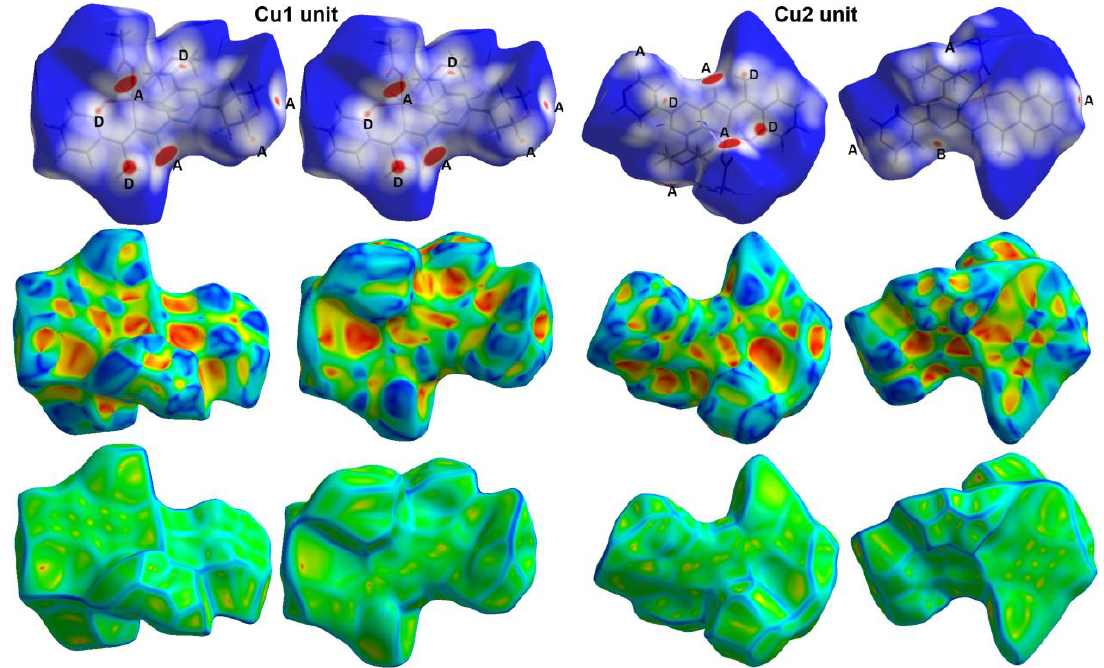
Figure 11. Hirshfeld maps of complex 2 . The most important interactions are ( A ) O…H , ( B ) N…H, ( C ) C…C and ( D ) H…C.